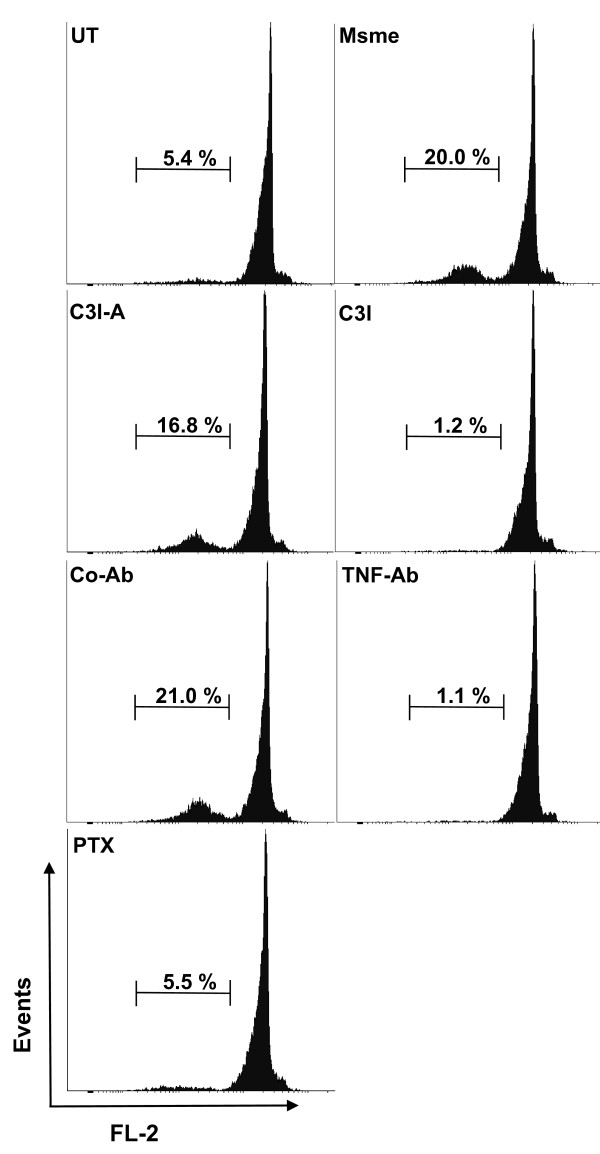
Macrophage apoptosis induction by a non-pathogenic mycoabcterium is caspase-3 and TNF-dependent. BMDMs from BALB/c mice were left untreated and uninfected (UT) or infected with M. smegmatis and then either left in medium (Msme) or treated with caspase-3 inhibitor (C3I), nonspecific chemical analog (C3I-A) neutralizing TNF antibody (TNF-Ab), nonspecific control Ab (Co-Ab) and TNF synthesis inhibitor pentoxifylline (PTX). The percentage of apoptotic cells out of 10,000 total cells was determined after 20 h using the hypodiploid PI flow cytometry assay and a representative histogram of two independent experiments performed in duplicates is shown.